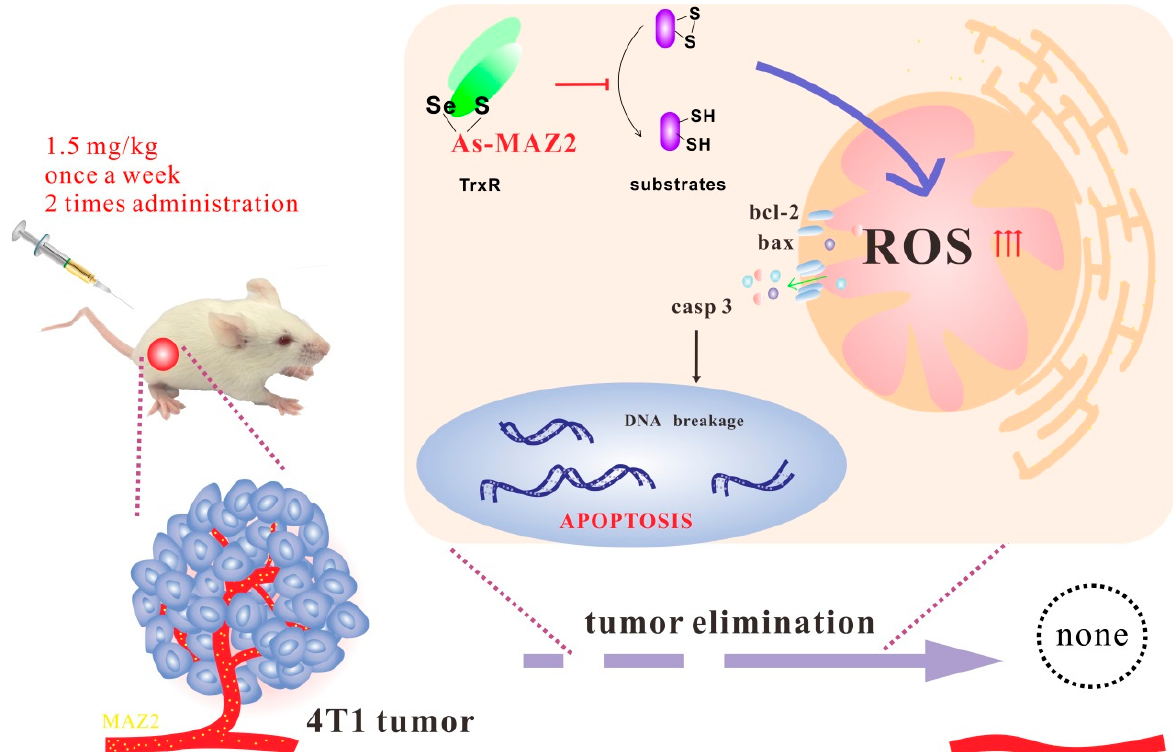
Figure 8. The mechanism of